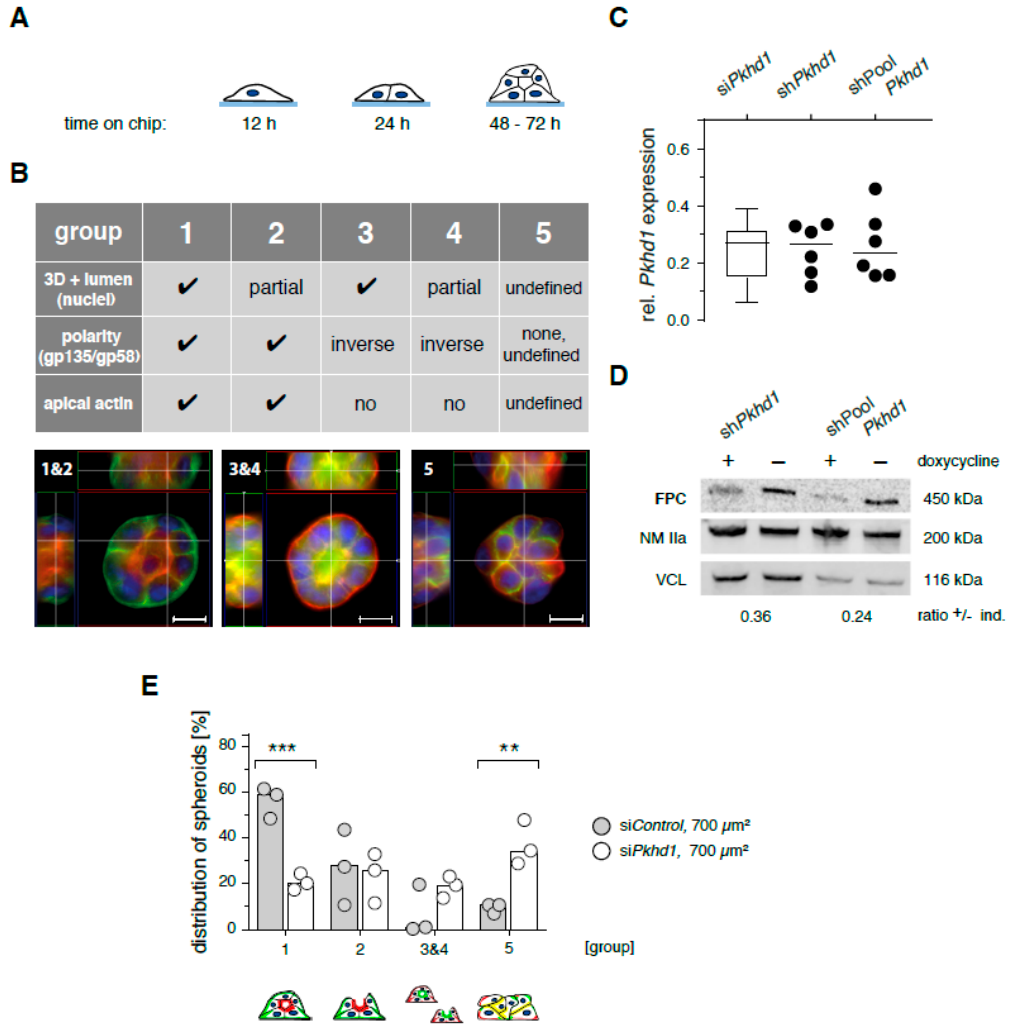
Figure 1. Induction and classification of epithelial spheroids; fibrocystin / polyductin (FPC)-deficient cells show defects in epithelial morphogenesis. ( A ) Madin-Darby Canine Kidney II (MDCKII) cells are seeded onto adhesion chips with extracellular matrix (ECM)-coated, disc-shaped micropatterns of 700 or 1600 µ m 2 . Single cells give rise to spheroids of 16 to 20 cells within 3 days of culture. ( B ) Classification of spheroids; fixed cell clusters are stained for gp58 (basolateral, green), gp135 / podocalyxin (apical, red), F-actin (not shown) and nuclei (DAPI, blue). Signals for podocalyxin and F-actin (phalloidin) correlate highly. Spheroids are analyzed based on blinded classification of z-stacks of 4-color fluorescence images. Size bars, 10 µ m. ( C ) To control e ffi ciency of knockdown, Pkhd1 mRNA levels were determined by real-time polymerase chain reaction (PCR) using the ∆∆ CT method relative to three reference genes. Pkhd1 expression is given as ratio of levels from si Pkhd1 to si Control -